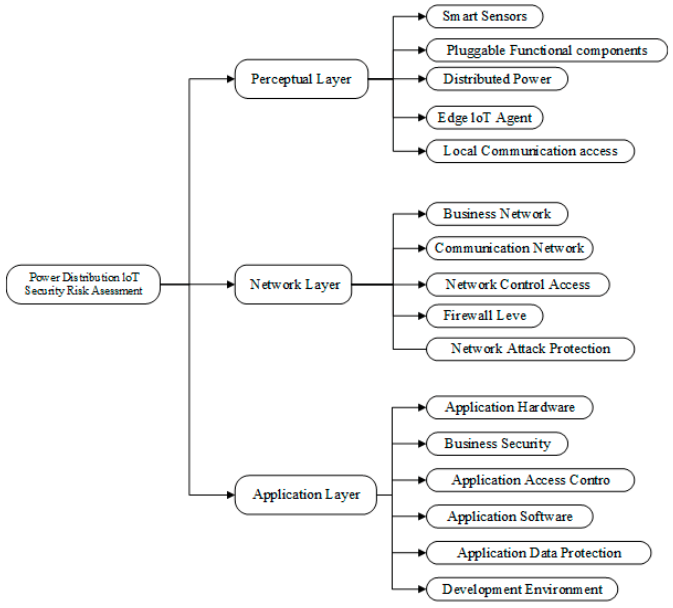
Figure 1. Evaluation index of three-layer architecture of PDIoT system.